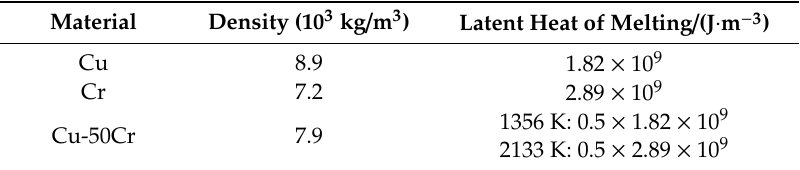
Table 3. Latent heat of the Cu phase, Cr phase, and Cu-Cr alloy,